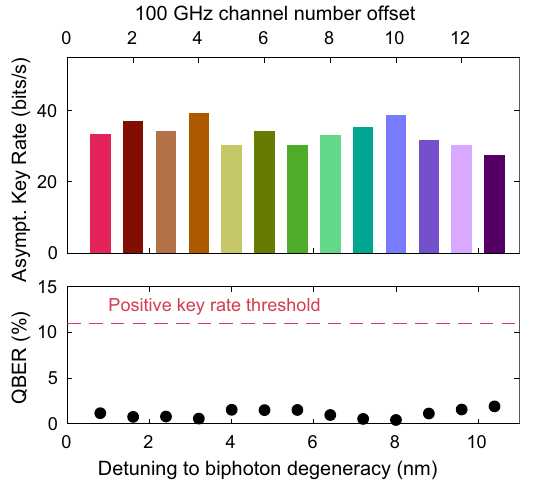
Fig. 3 BBM92 performance at 0 km. Asymptotic BBM92 key rate (upper panel) and QBER (lower panel) as a function of the detuning to biphoton degeneracy in nm (lower x -axis) and in units of 100 GHz channels (upper x -axis). The 11% error threshold for a positive key rate is given for an error-correcting code operating at the Shannon limit.